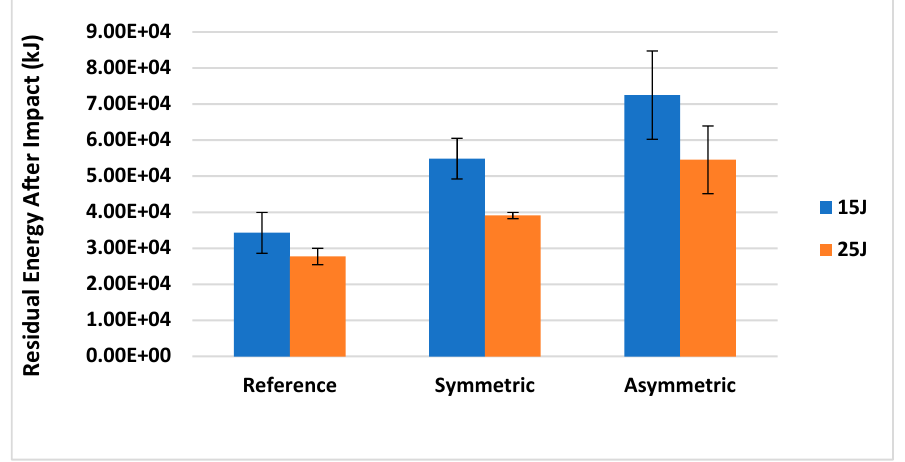
Figure 15. Results of the FAI tests.